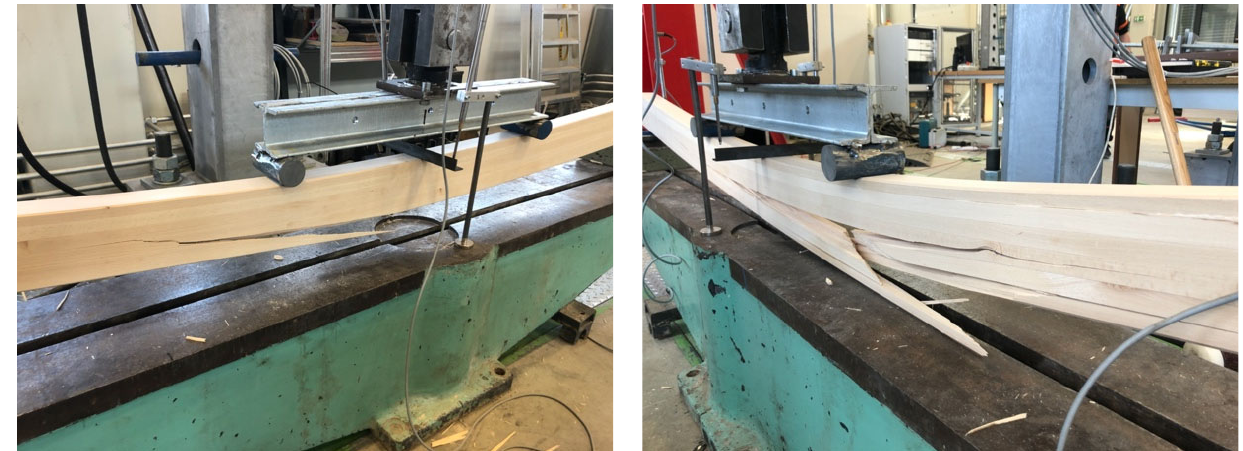
Figure 8. Examples of failure of the homogeneous beech beam (BE (h)) (authors’ archive). For most of the hybrid beech–poplar beam specimens, the first visible failure (crack propagation) was observed in the tensile zone. However, in some specimens, there were failures of poplar lamellae in the inner zone, while the beech lamellae stayed intact in the tensile zone. Failure of the poplar lamellae in these specimens often occurred in the shear (Figure 9).